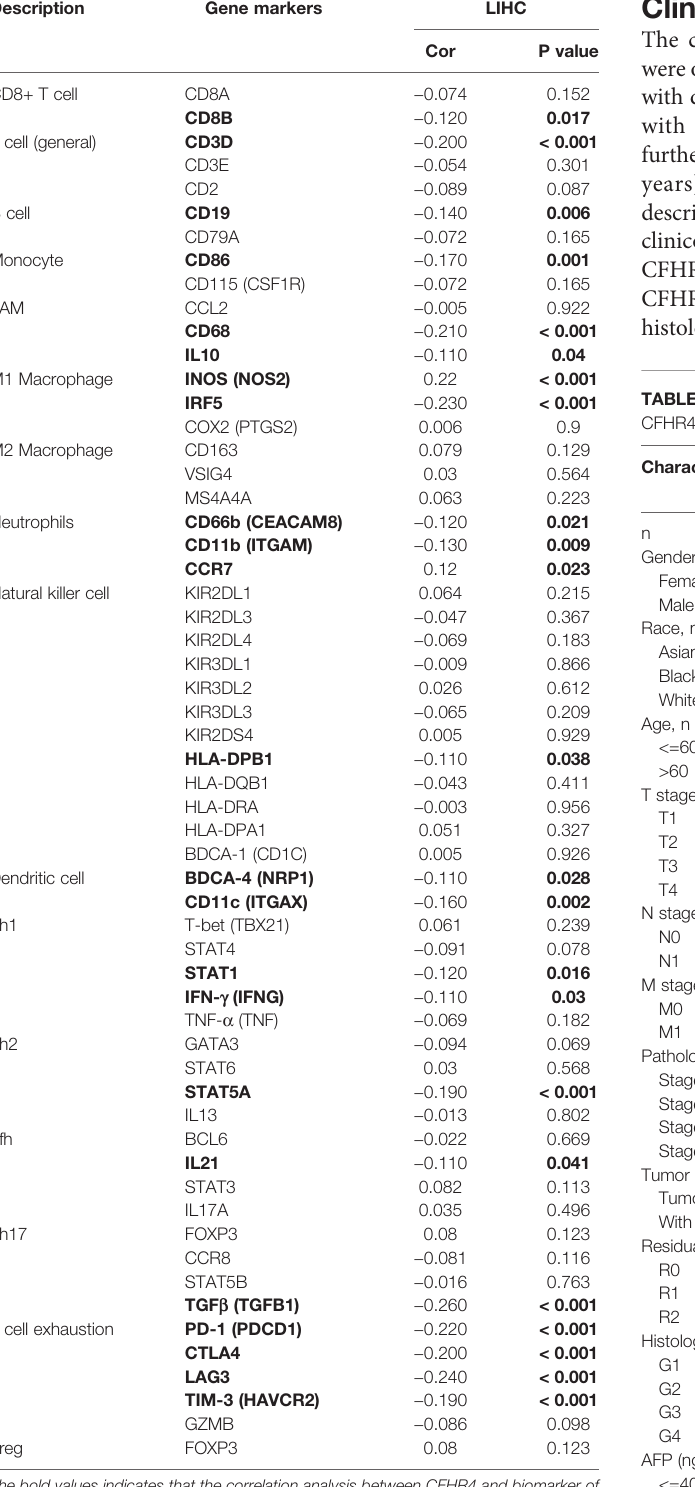
TABLE 1 | Correlation analysis between CFHR4 expression and biomarkers of immune cells.